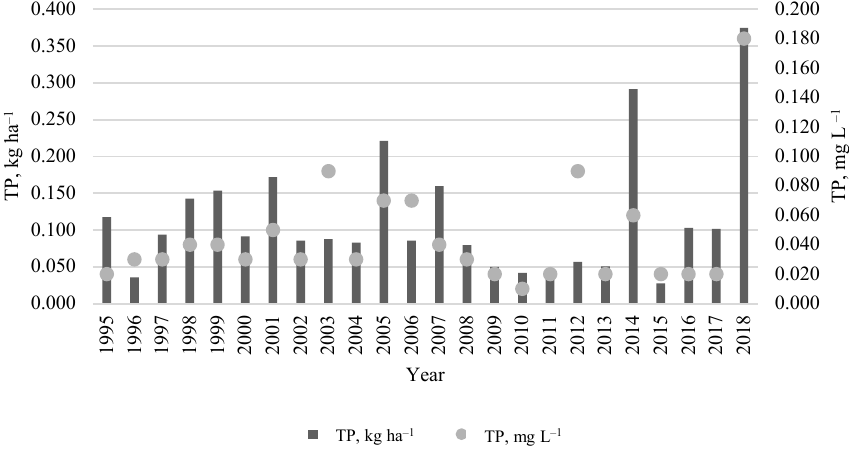
Fig. 7. Annual losses (kg ha -1 ) and concentrations (mg L -1 ) of total phosphorus (TP) in the Vienziemite small